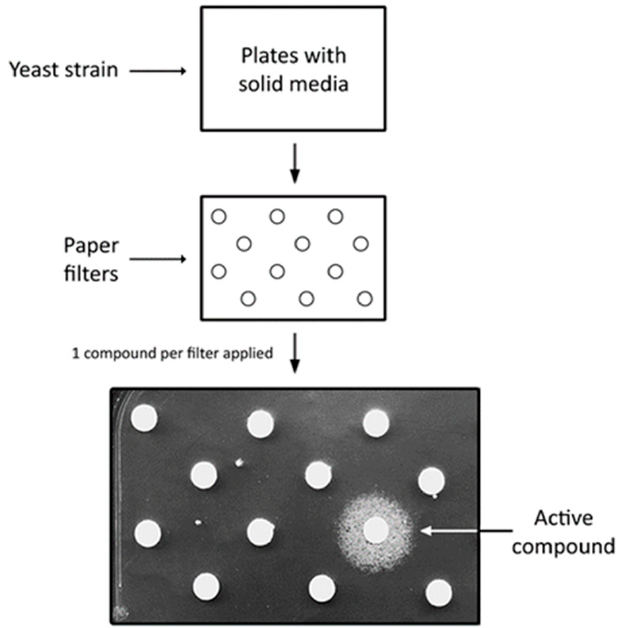
Figure 1. Scheme of a chemical suppressors screen using yeast. The presence of a growth zone around the paper filter indicates that an active compound has been spotted onto the filter. Figure adapted from Soczewka et al. (2020) [42].